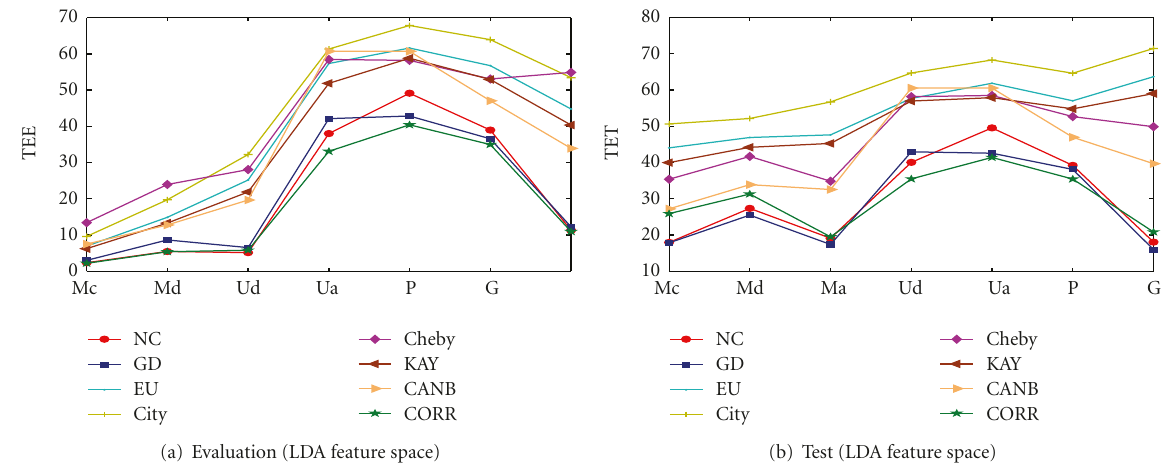
Figure 3: ID verification results using di ff erent scoring functions in the LDA feature space for automatically registered